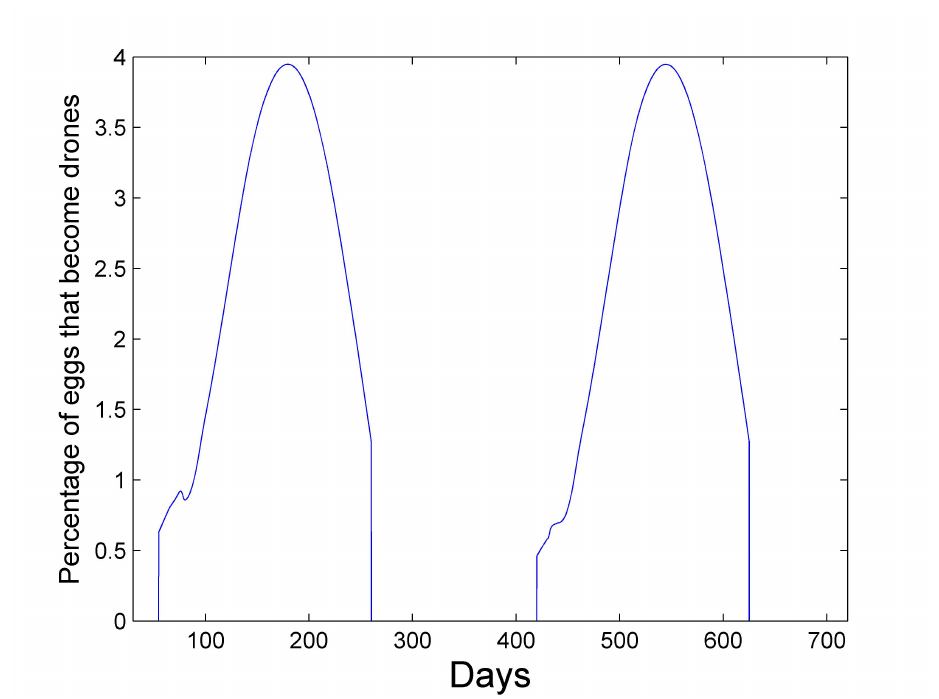
Figure 3. Percentage of eggs that become drone eggs using Equation (15) at latitude 35 ◦ . The average percent value over the two years is 2.5% during the summer.